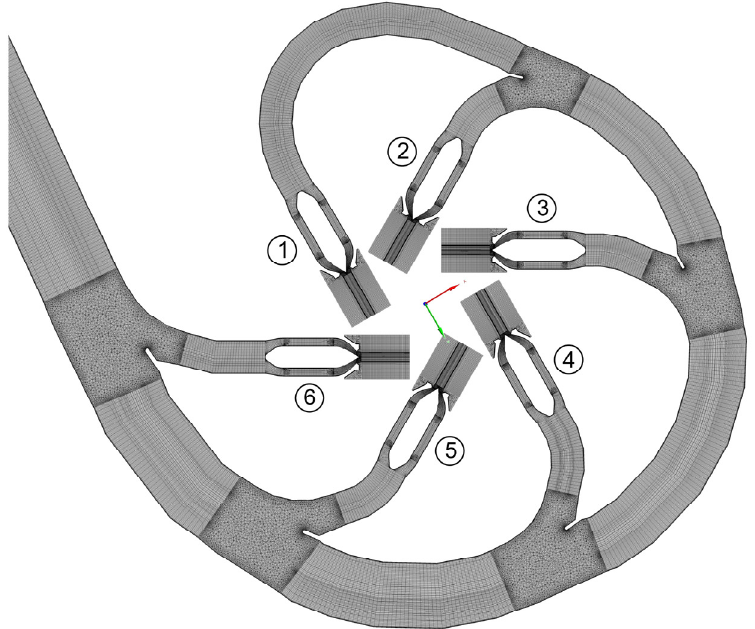
Figure 3. Distributor mesh in the symmetry plane with nozzle numbering and global coordinate system.